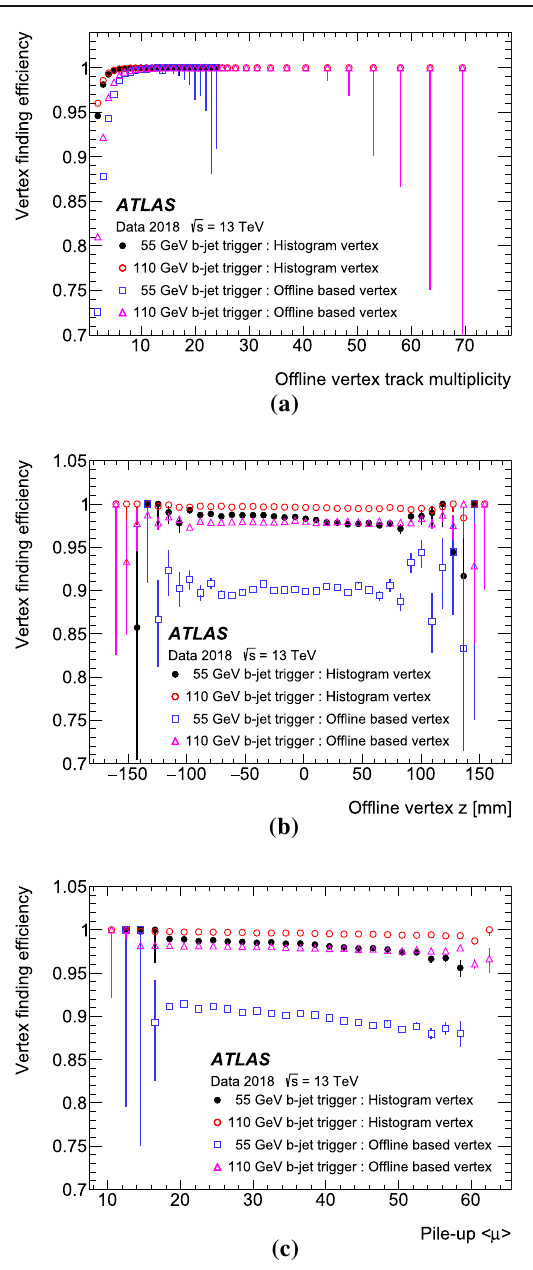
Fig. 41 The vertex algorithm efficiencies for low and intermediate E T b -jettriggers. Shown are theefficiencies a versus theoffline trackmulti- plicity for tracks in the super RoI; b versus the z 0 position of the offline vertex; and c versus the mean pile-up interaction multiplicity. Statisti- calBayesianuncertaintiesareshown,usinga68.3%confidenceinterval and uniform beta function prior